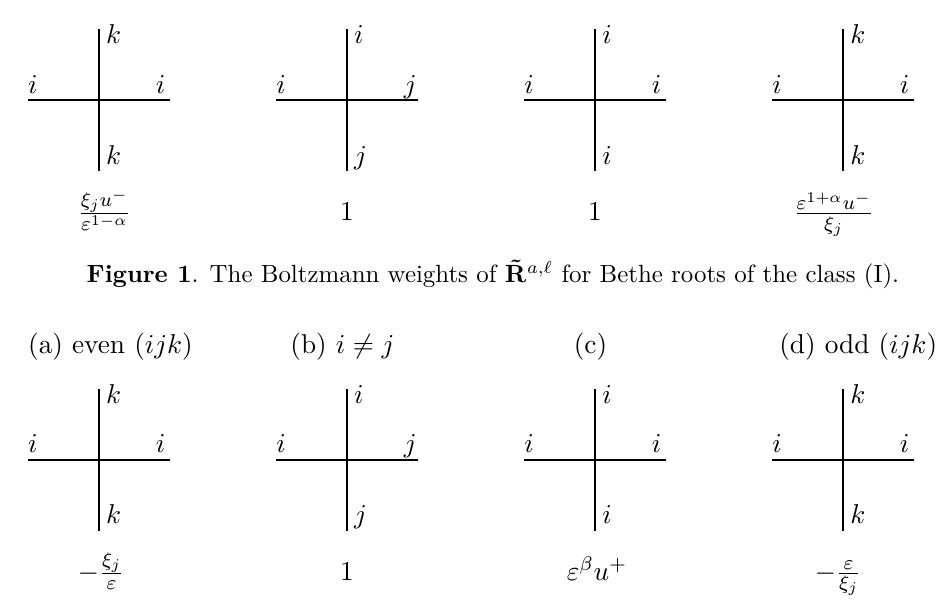
Figure 2 . The Boltzmann weights of ˜R a,‘ for Bethe roots of the class (II). n , · · · , n , the number of 2 ’s should be M 0 , that of 3 ’s be K , and that of 1 ’s be L − M 1 L